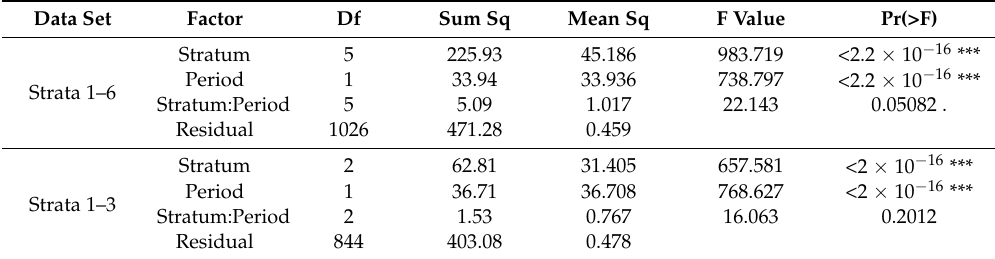
Table A3. Two-way ANOVA with interaction. Variables: Members per household.